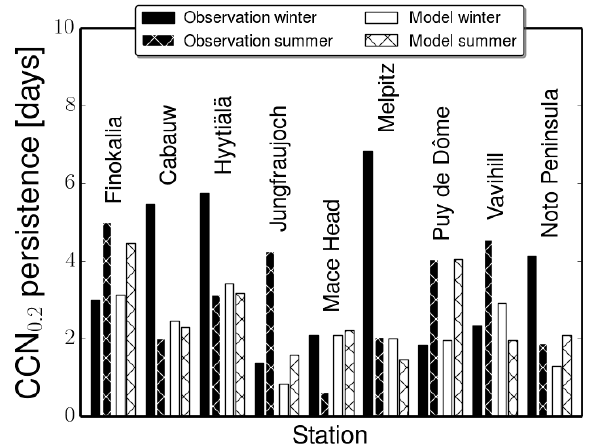
Figure 7. Comparison between the observed and the mean of the model-derived persistence (days) of CCN 0 . 2 during winter (left bar) and summer (right shaded bar) for each station. The observed per- sistence times are shown in black for each station and the mean of the model-derived persistence times in white. The persistence times obtained from model simulations have been computed at the same time periods as the observed